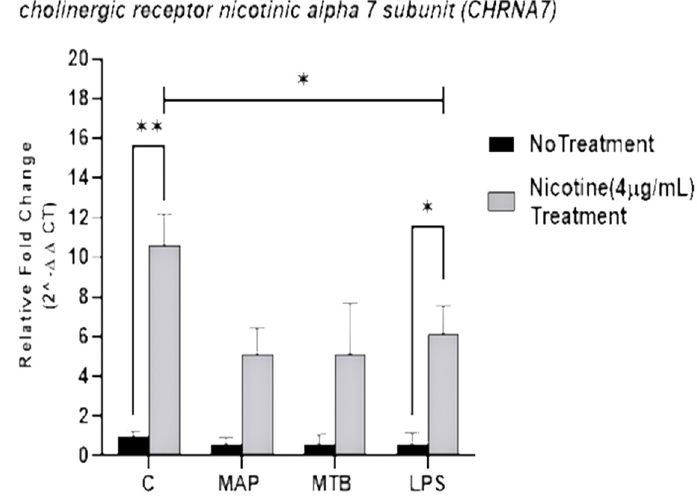
Figure 1. Effect of nicotine on the α 7nAChR expression on infected macrophages. THP-1 PMA differentiated macrophages were infected with MAP and MTB, or treated with LPS for 24 h, then treated with nicotine (4 µg/mL). Expression of α 7nAChR was measured by RT-PCR. All experiments were performed in duplicate. MAP: Mycobacterium avium paratuberculosis . MTB: Mycobacteria tubercalusis . LPS: lipopolysaccharide derived from Escherichia coli ATCC 8739. * p < 0.05, ** p < 0.001.